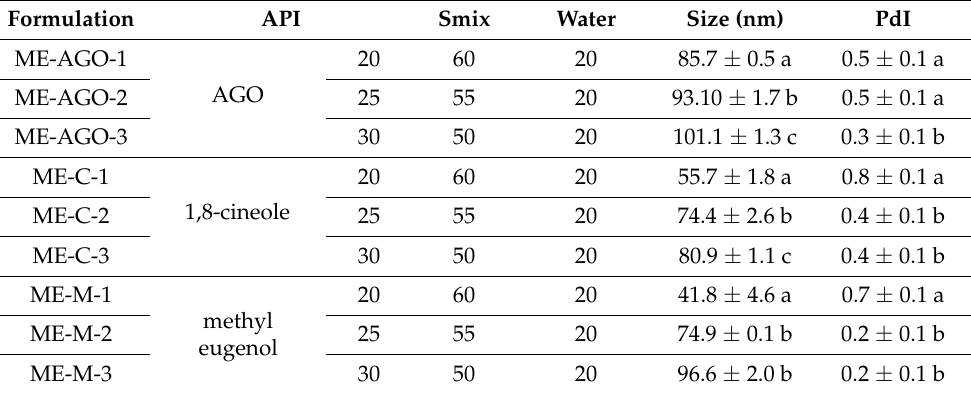
Table 1. Composition of microemulsion (ME) formulations (% w/w ).